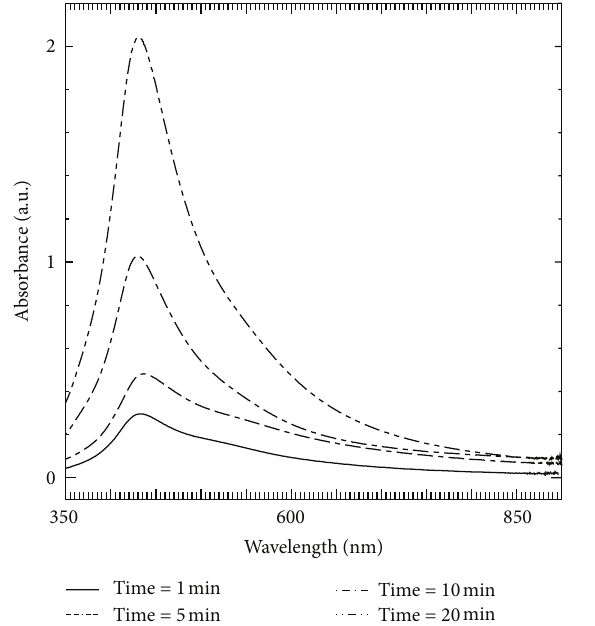
Figure 4: Optical absorption spectra of Ag NPs film at various deposition times of 1, 5, 10, and 20min.